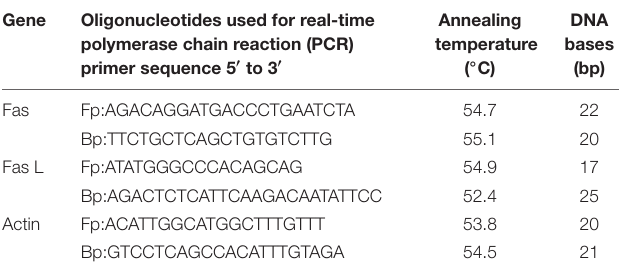
Annealing temperature